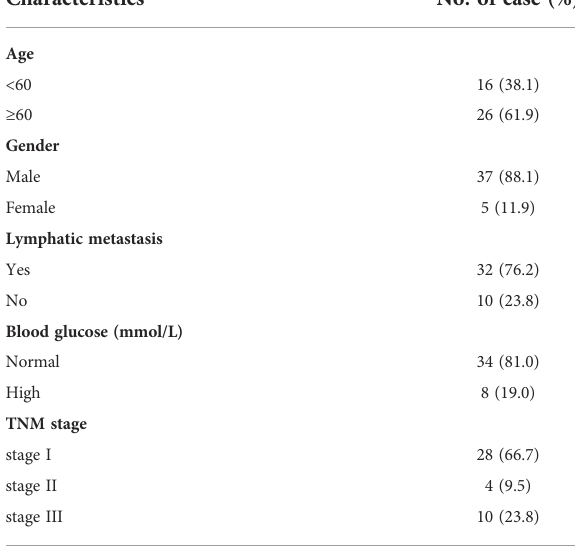
TABLE 1 Clinicopathological characteristics of OSCC patient samples.